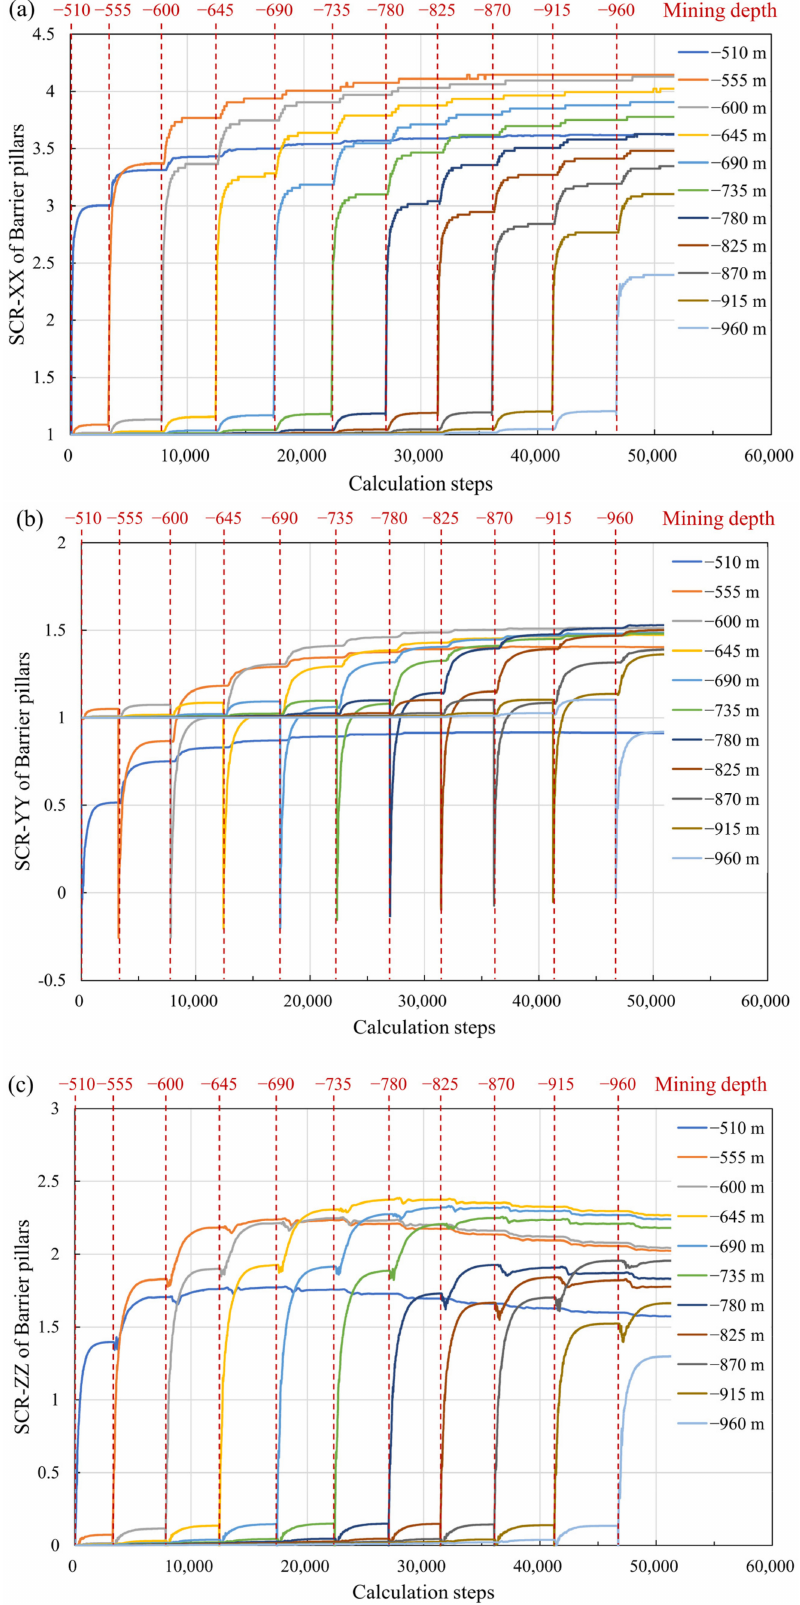
Figure 9. The change law of the stress concentration ratio (SCR) of the barrier pillars at different depths: ( a ) the SCR in the XX direction, ( b ) the SCR in the YY direction, and ( c ) the SCR in the ZZ